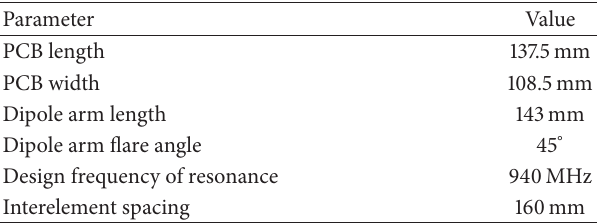
Table 1: Dipole antenna element design parameters and dimen-